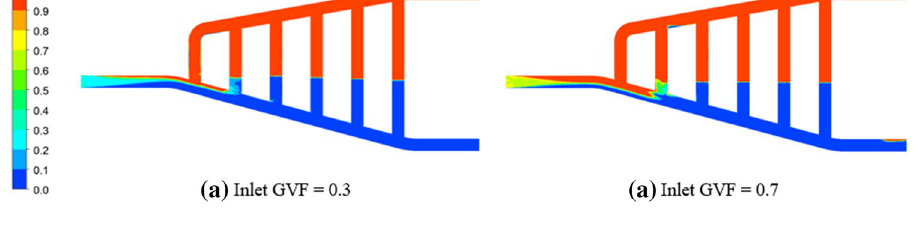
Fig. 9 GVF plots showing